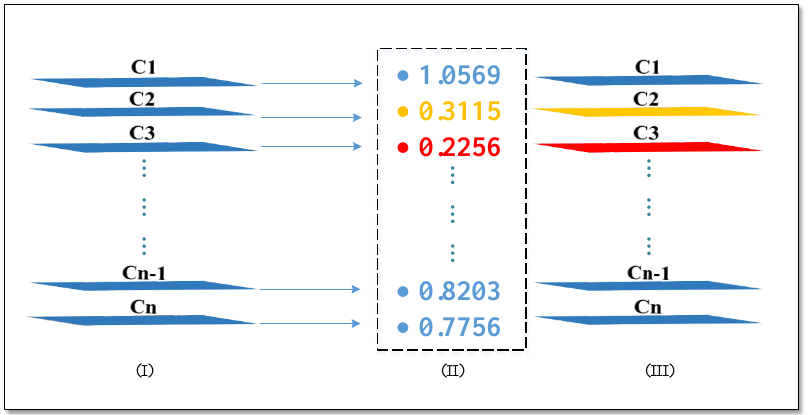
Figure 6. I, II, and III indicate the i -th feature map channels, 𝛾 parameters of the i -th batch normal- ization layer, and the i -th feature map channels which could be deleted, respectively.